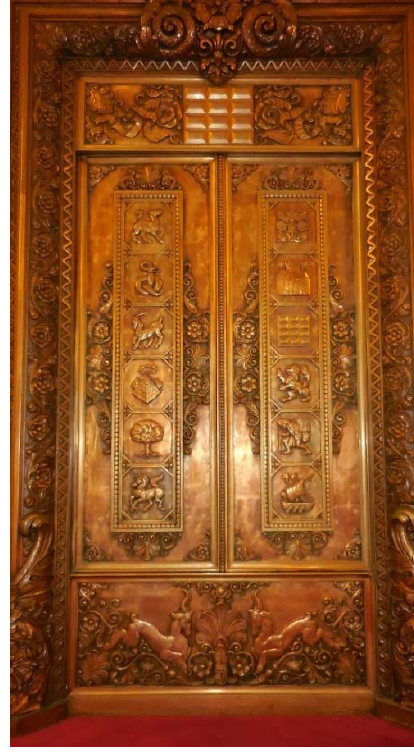
Figure 14. Detail, ark doors.